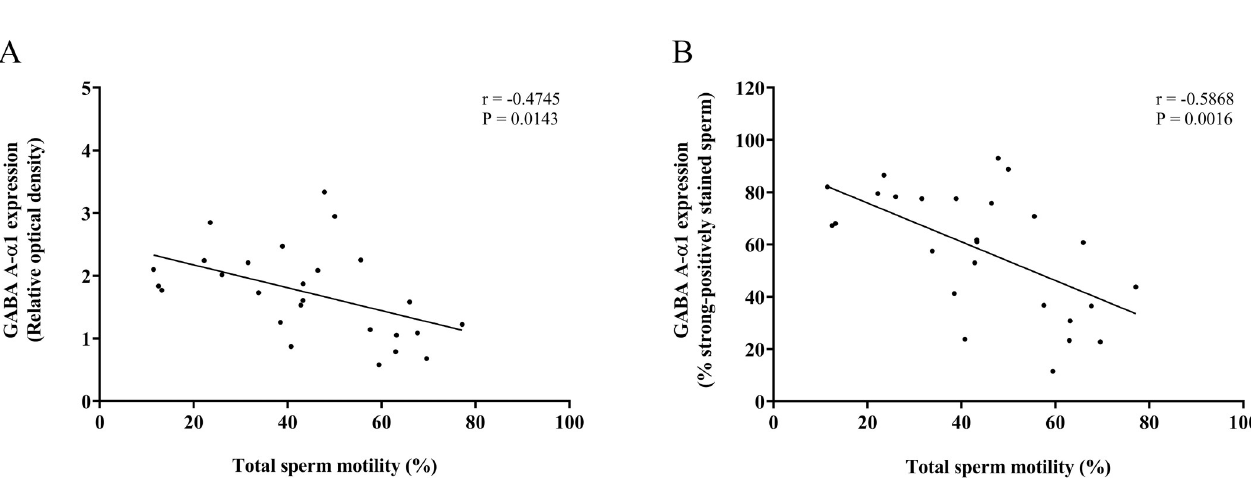
PLOS ONE | https://doi.org/10.1371/journal.pone.0273888 January 4, 2023 14 /